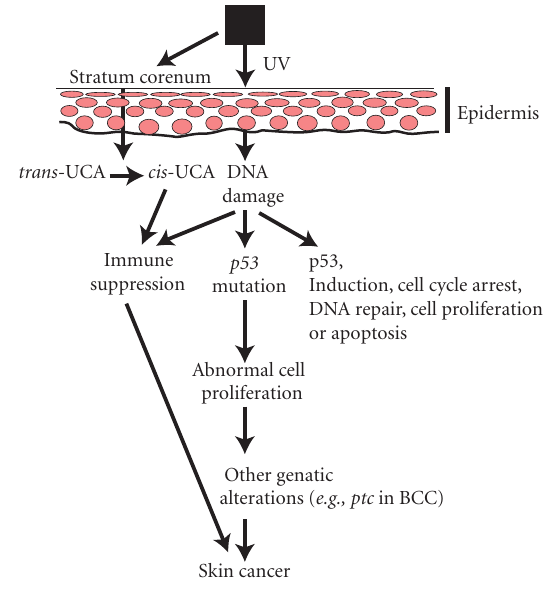
Figure 1: Pathways involved in skin cancer